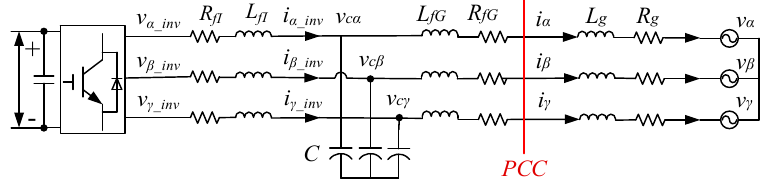
Figure 3. Schematic diagram of an LCL-filter interfaced IBR unit.